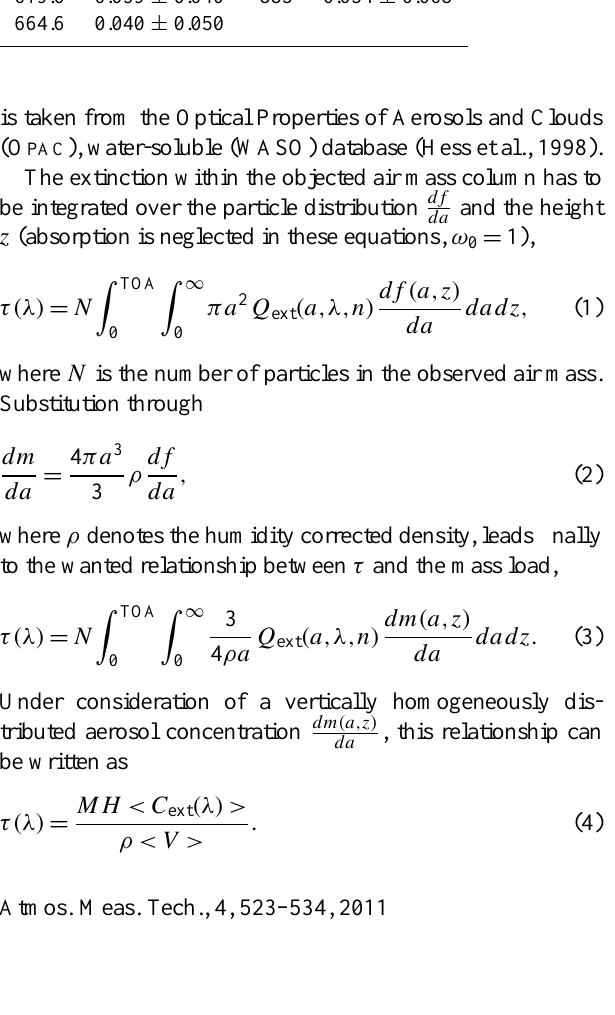
Table 1. Offsets and standard deviations for the comparisons of aerosol optical depth over Hamburg for ten cloud-free days in 2006 (see Fig. 4). λ Bias, Std.-Dev. 412.5